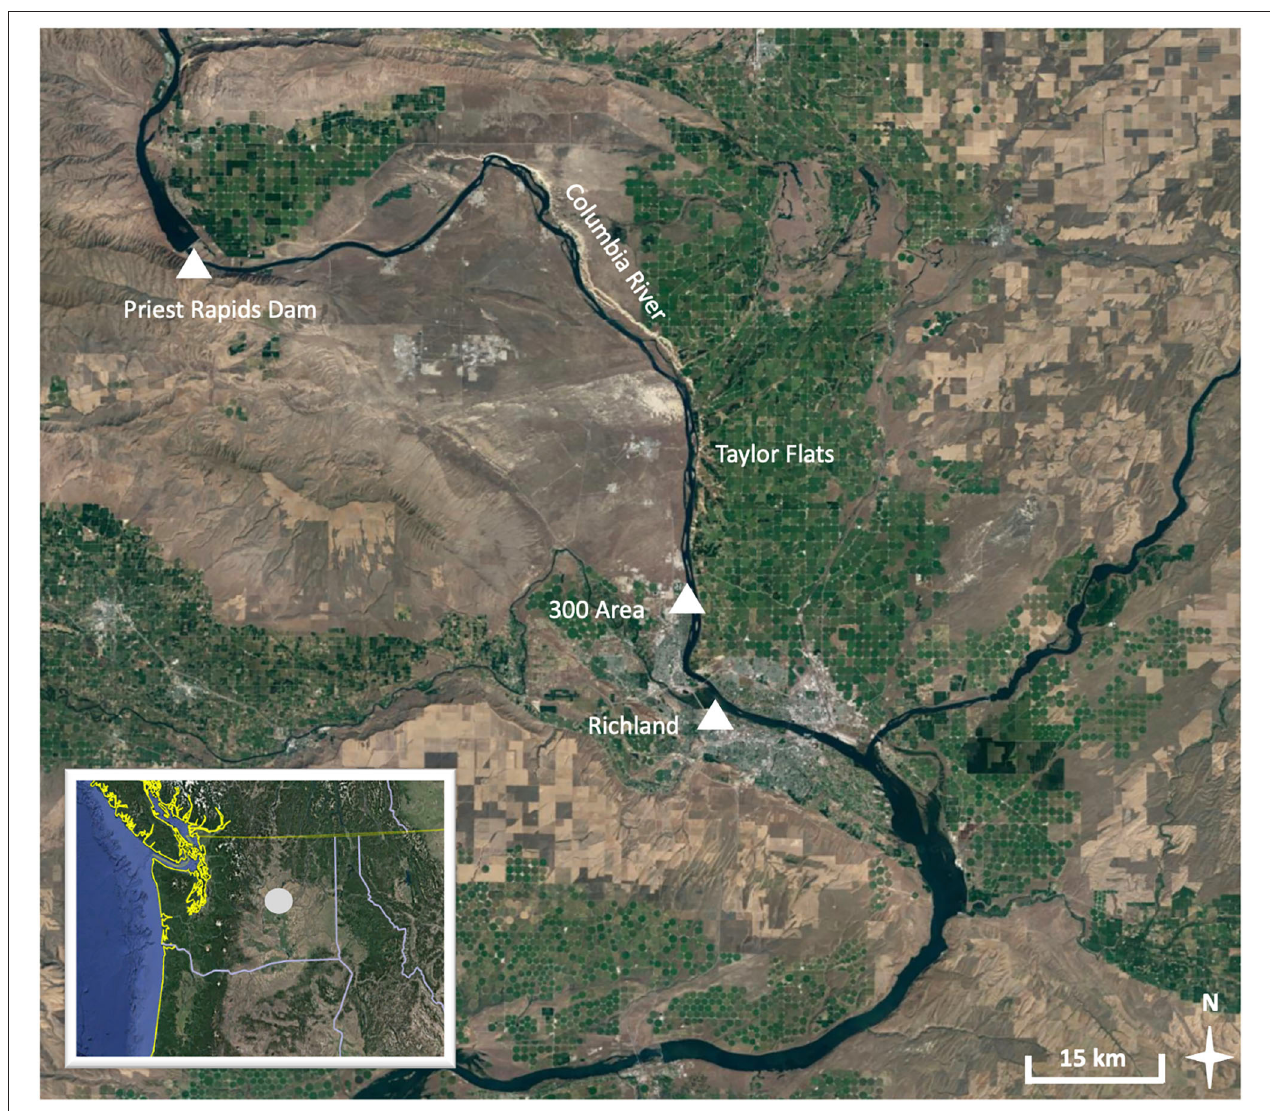
FIGURE 1 | Map of Hanford reach. This map shows the location of the Hanford Reach in Washington State (inset) and a satellite view of Hanford Reach. The Reach begins below the Priest Rapids Dam (46.643578N, 119.910357W), and continues until the confluence with the Snake River. Note the green coloring, indicating locations of irrigation, in contrast to the native brown landscape. Map data from Google,